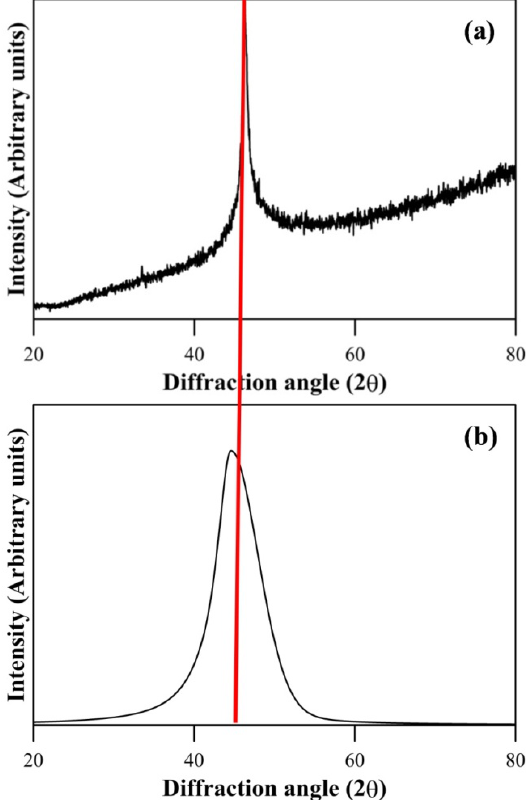
Figure 10. XRD analysis of Ni-P-W coating for the (a) initial test run and (b) optimal parametric